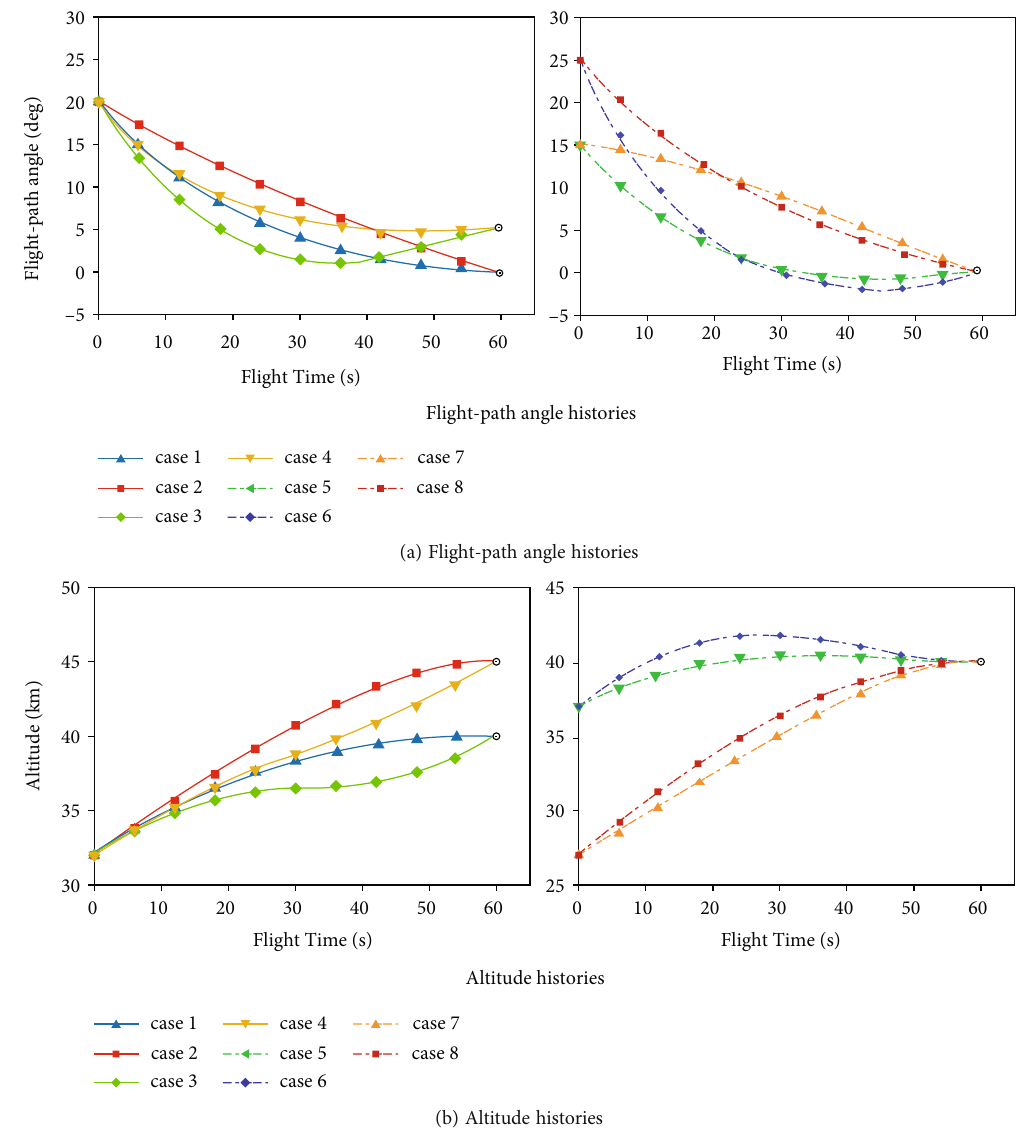
Figure 7: Flight-path angle and altitude histories for di ff erent cases. Table 7: Terminal errors with close-loop